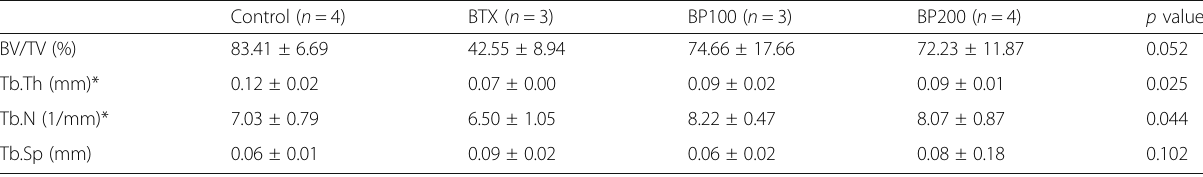
*Significant difference ( p <0.05),